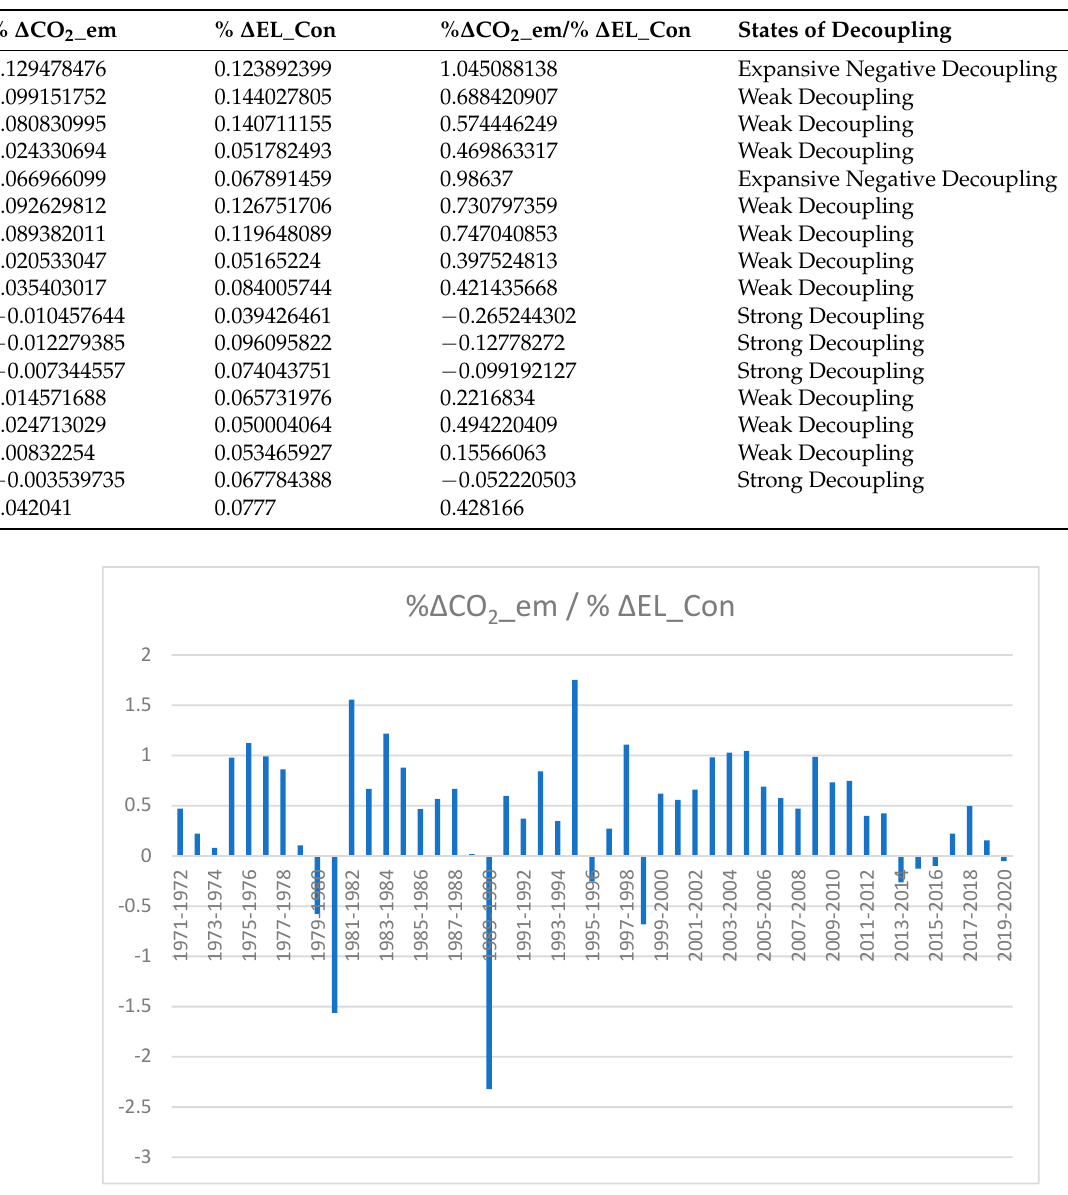
Figure 6. The states of decoupling of CO 2 emissions and consumption of electricity in China during